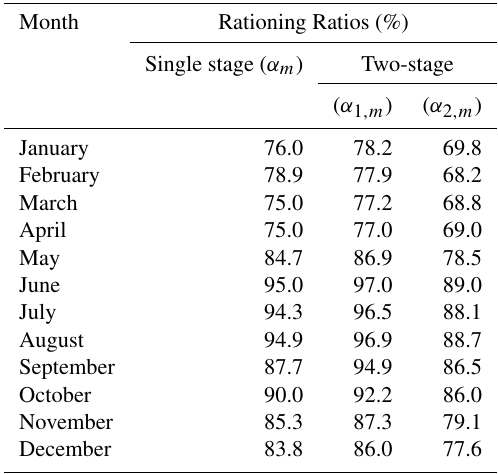
Table 2. Rationing ratios for monthly varying hedging policies.